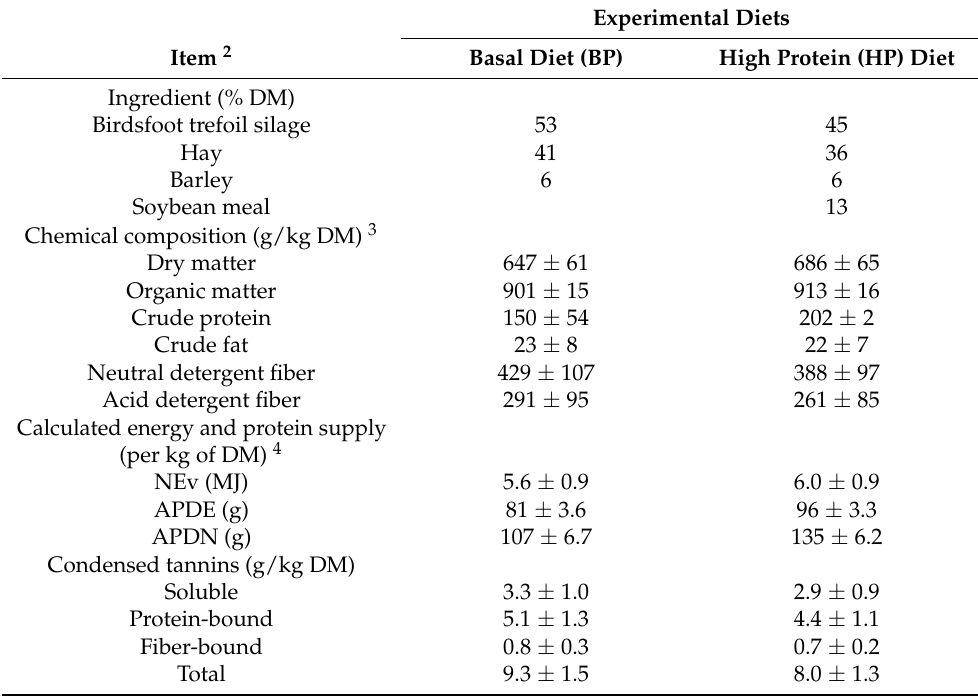
Table 1. Ingredients and gross chemical composition of the experimental diets used in experimental periods 1 and 2 1